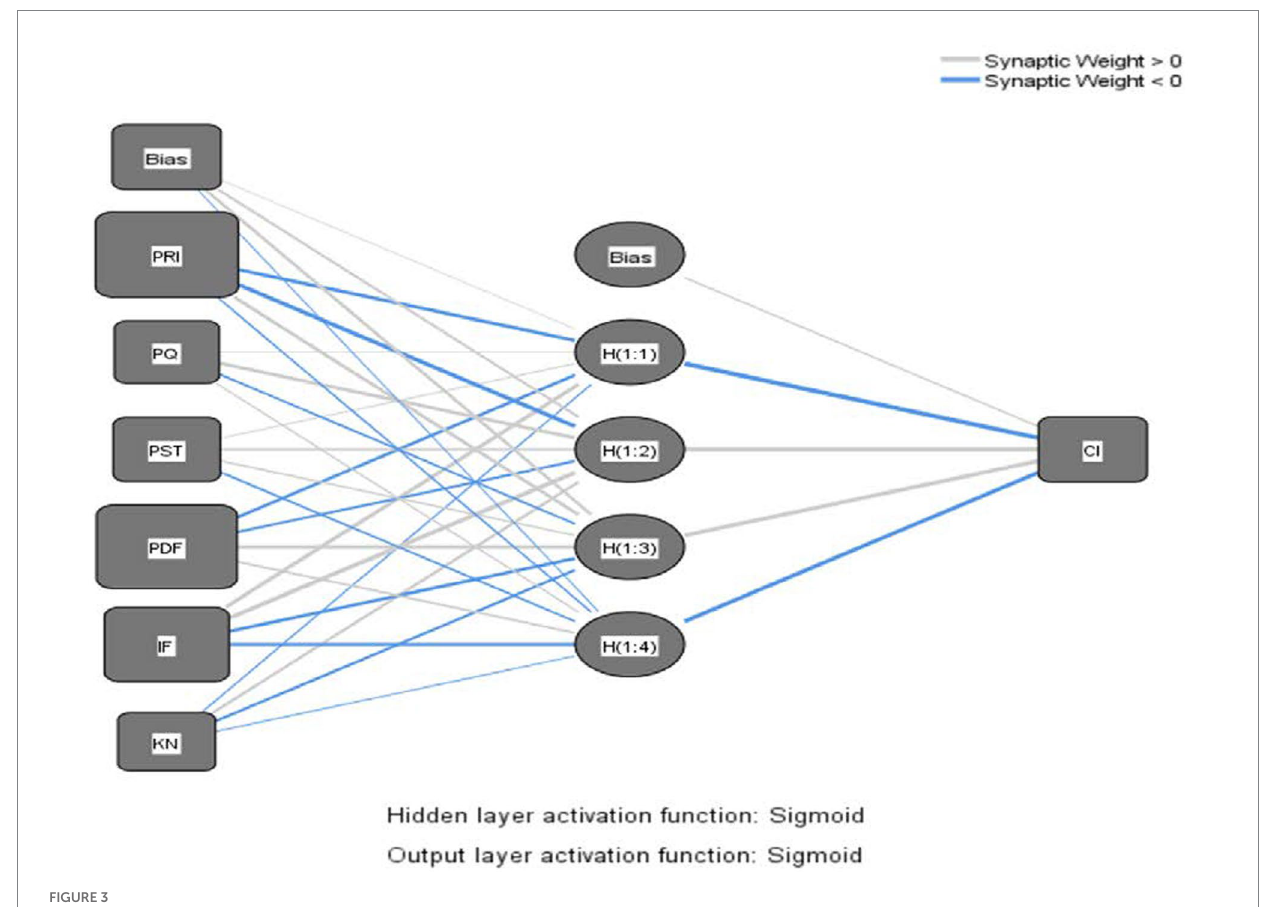
FIGURE 3 Neural network model – product cognitive